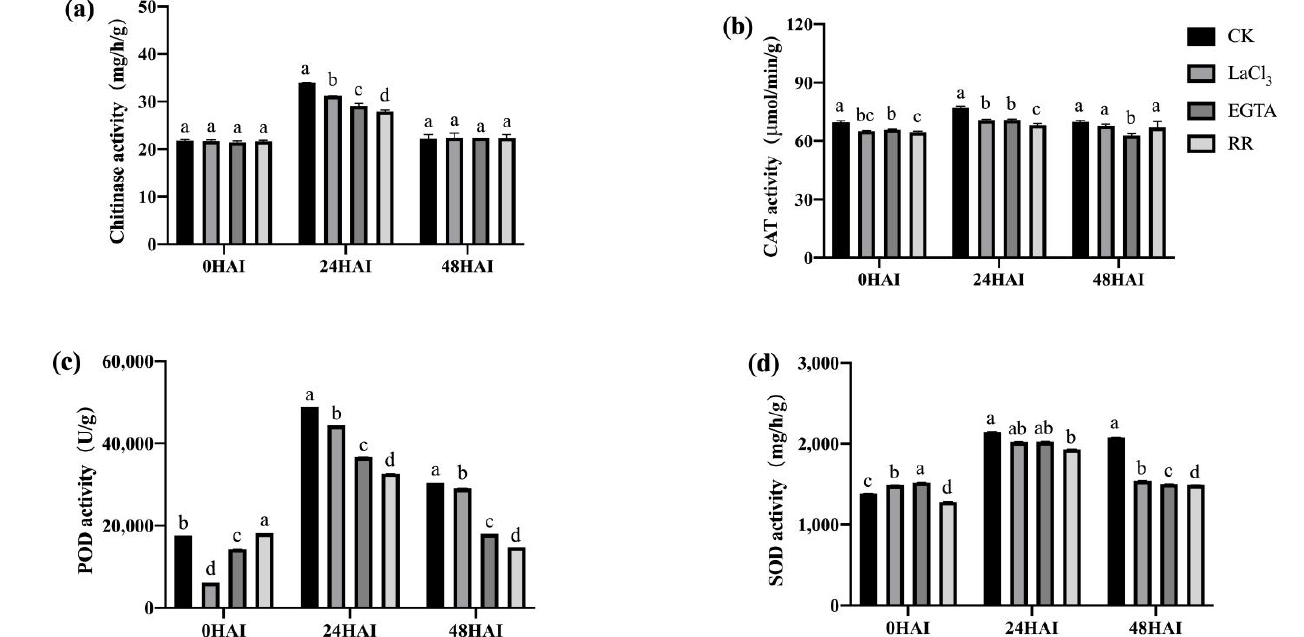
Figure 11. Ca 2+ chelating agent/channel inhibitor treatments inhibited the activities of chitinase ( a ), CAT ( b ), POD ( c ), and SOD ( d ) in high-vigor maize seeds under F. graminearum infection. EGTA, ethylene glycol-bis(beta-aminoethyl ether)- N -tetraacetic acid; RR, Ruthenium Red; CK, control; HAI, hours after inoculation. Different letters indicate significant differences among different lines (Tukey’s test).